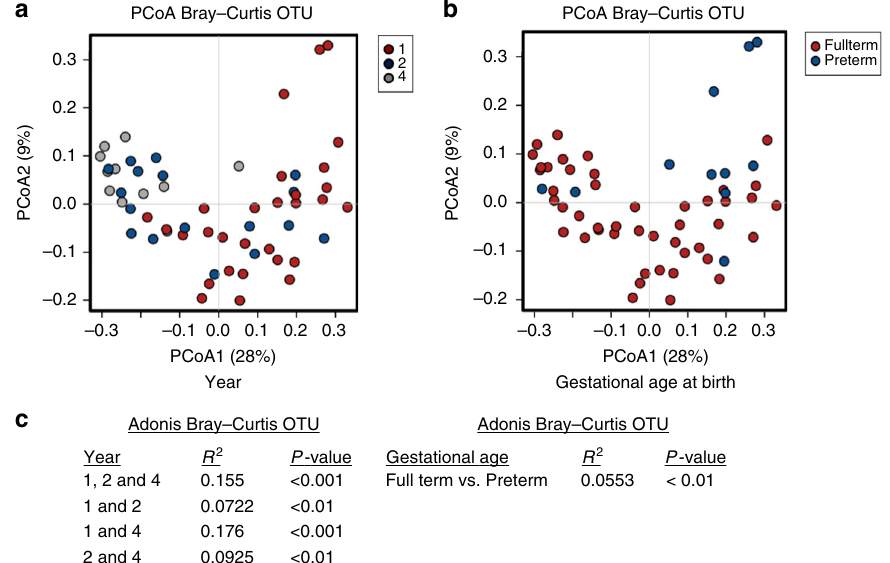
Fig. 3 Separation of samples using beta diversity data based on age and gestational age at birth. a Principal coordinate analysis (PCoA) based on Bray – Curtis operational taxonomic unit (OTU) data on independent samples at years one, two and four (individuals sampled at one time point). b PCoA based on Bray – Curtis OTU data on independent samples based on gestational age at birth. c Adonis variance analysis based on Bray – Curtis distance matrices at OTU level. Source data are provided as a Source Data fi le. (* p < 0.05, ** p < 0.01, *** p < 0.001)